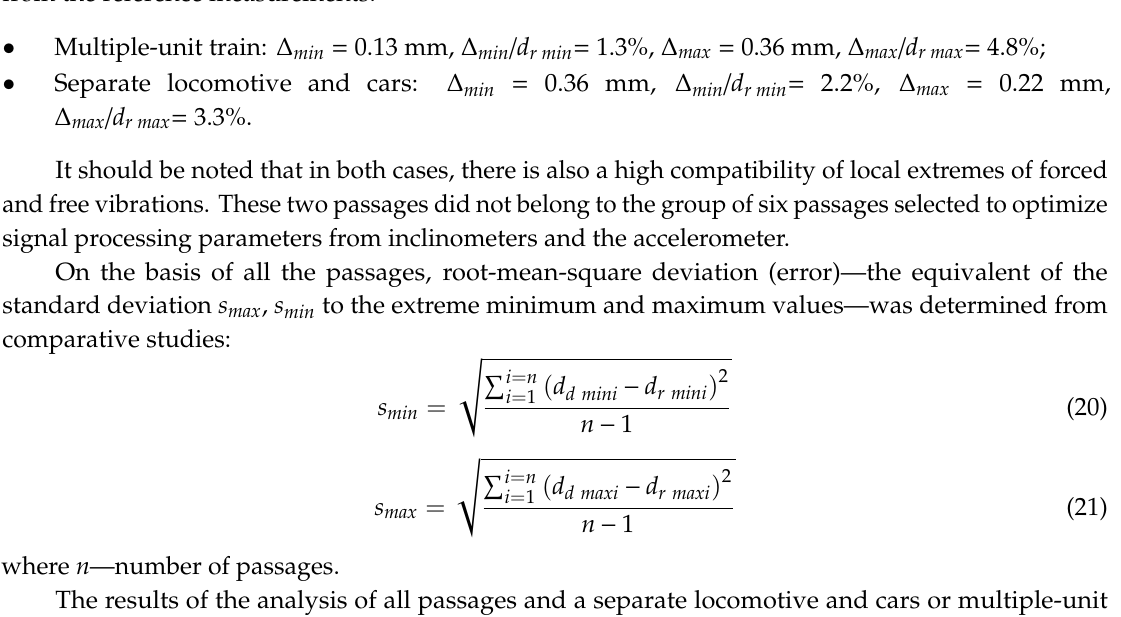
Table 2. Root-mean-square deviation for all trains, multiple-unit trains, and separate locomotive and cars passages. Root-Mean-Square Deviation s Train